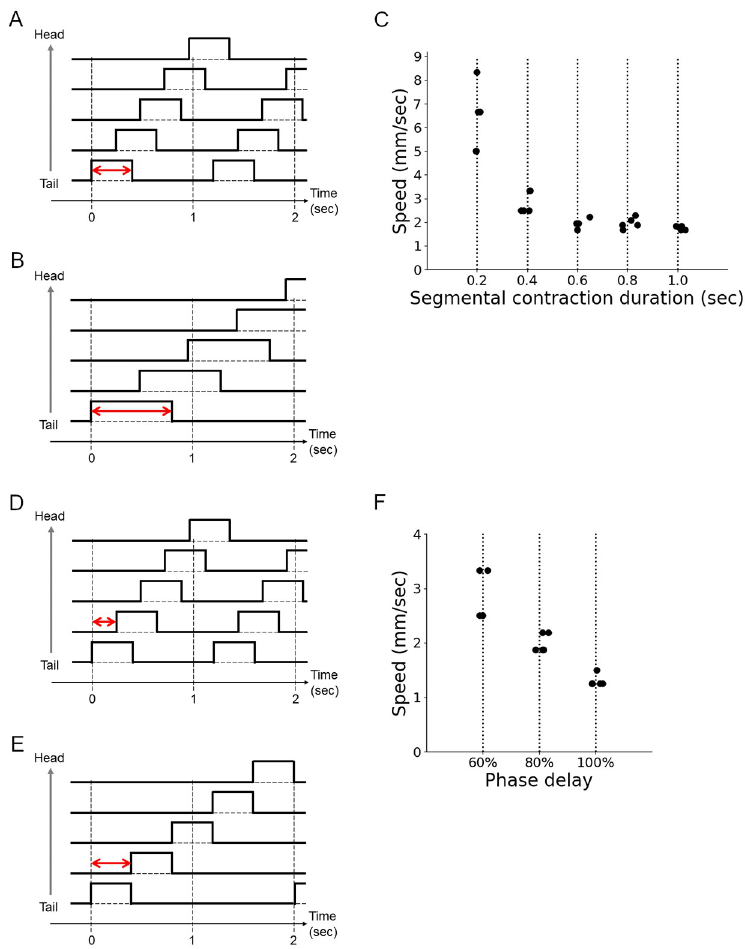
Fig 10. Involvement of segmental contraction duration and intersegmental phase delay in crawling speed. (A and B) Control signals with different segmental contraction duration (double-headed arrows) for the soft robot. (A) The segmental contraction duration is 0.4 sec. (B) The segmental contraction duration is 0.8 sec. The intersegmental phase delay is the same in (A) and (B). (C) Locomotion speed of the soft robot with different segmental contraction duration (p-value = 1.1 x 10 − 4 by one-way ANOVA). (D and E) Control signals with different intersegmental phase delays (double-headed arrows) for the soft robot. (D) The intersegmental phase delay is 60%. (E) The intersegmental phase delay is 100%. The segmental contraction duration is the same in (D) and (E). (F) Locomotion speed of the soft robot with a different intersegmental phase delay (p-value = 0.015 by one-way